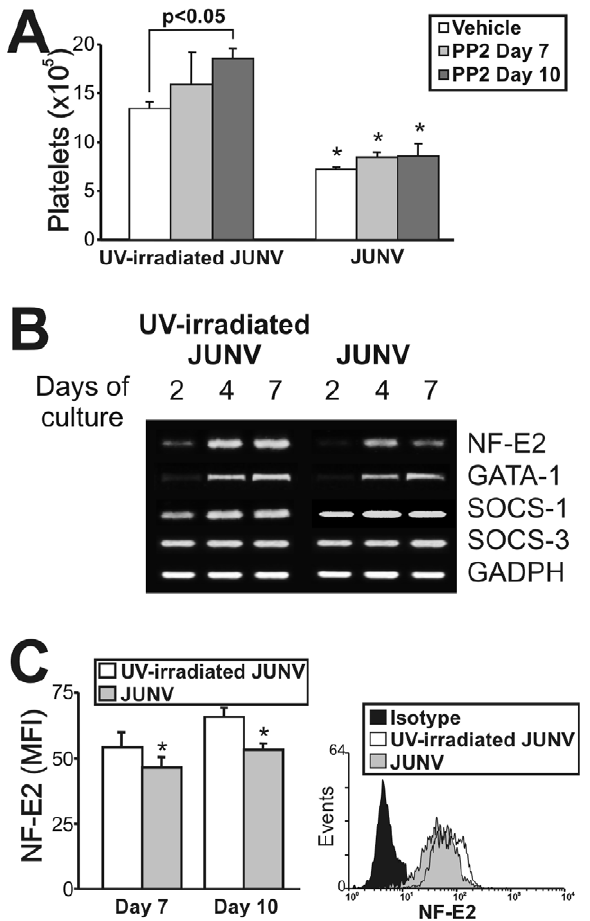
Figure 7. Intracellular mechanisms involved in the JUNV- induced inhibition of platelet production. CD34 + cells were UV- irradiated JUNV- or JUNV-infected, washed and stimulated with TPO. (A) The Src inhibitor PP2 (10 m M) was added at the indicated days, and Plt counts were determined at culture day 15. The values represent the mean 6 SEM of four independent experiments, * indicates p , 0.05 vs. UV-irradiated JUNV-treated cells. (B) Semi-quantitative RT-PCR analysis of relevant molecules involved in megakaryo/thrombopoiesis were performed at the indicated days of culture. The figure shows a representative experiment of three similar replicates. (C) NF-E2 expression was assessed in the megakaryocytic population by immunostaining the cells first with a PE-conjugated anti-CD41 mAb or an isotype-matched control. Then the cells were incubated with anti- NF-E2 polyclonal followed by FITC-conjugated swine anti-rabbit Igs. Cells were analyzed by flow cytometry. Non-specific fluorescence was assessed using rabbit serum instead of primary Ab. The values represent the mean 6 SEM of three independent experiments,* indicates p , 0.05 vs. UV-irradiated JUNV-infected cells. The histogram shows a represen- poly(I:C) is recognized by TLR3, which predominantly stimulates the expression of NF-kB and IFN b [40]. Therefore, IFN b appeared to be a suitable mediator responsible for the reduced platelet production mediated by JUNV infection of hematopoietic cells. Our results showing: a) the JUNV-dependent induction of IFN b mRNA synthesis, b) the suppressive effect of IFN b on platelet biogenesis, c) the expression of both subunits of the IFN b